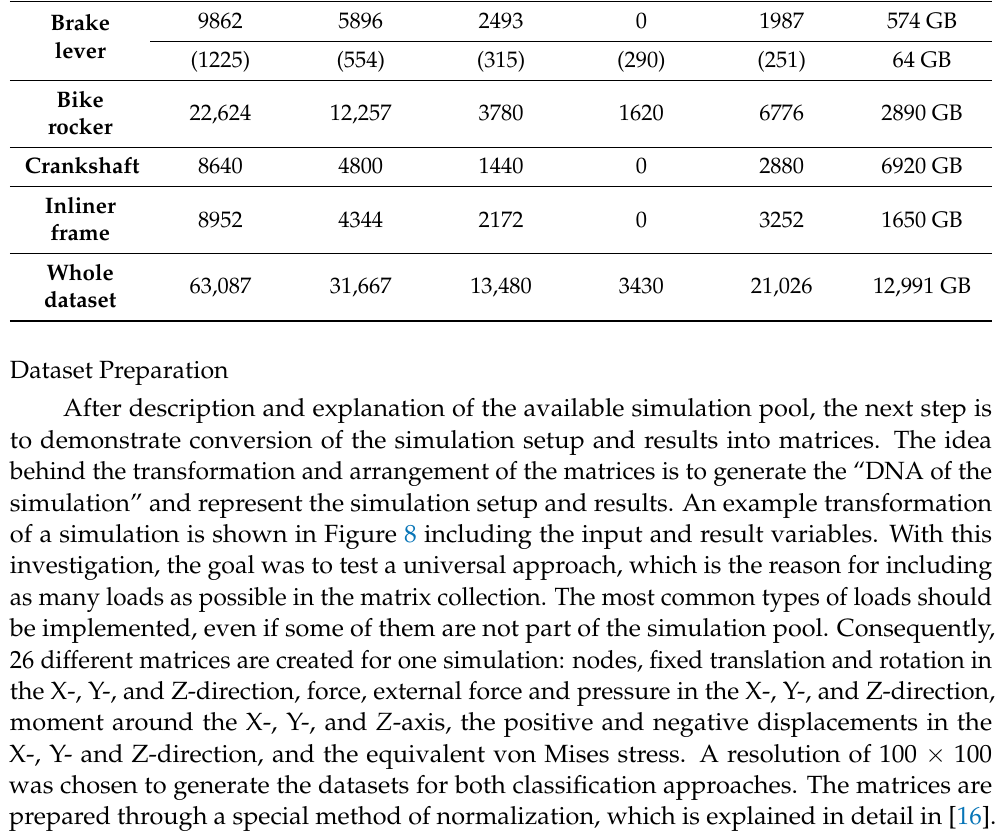
Table 2. General information about the demonstrative study simulation datasets, with the numbers of the additional dataset in brackets.